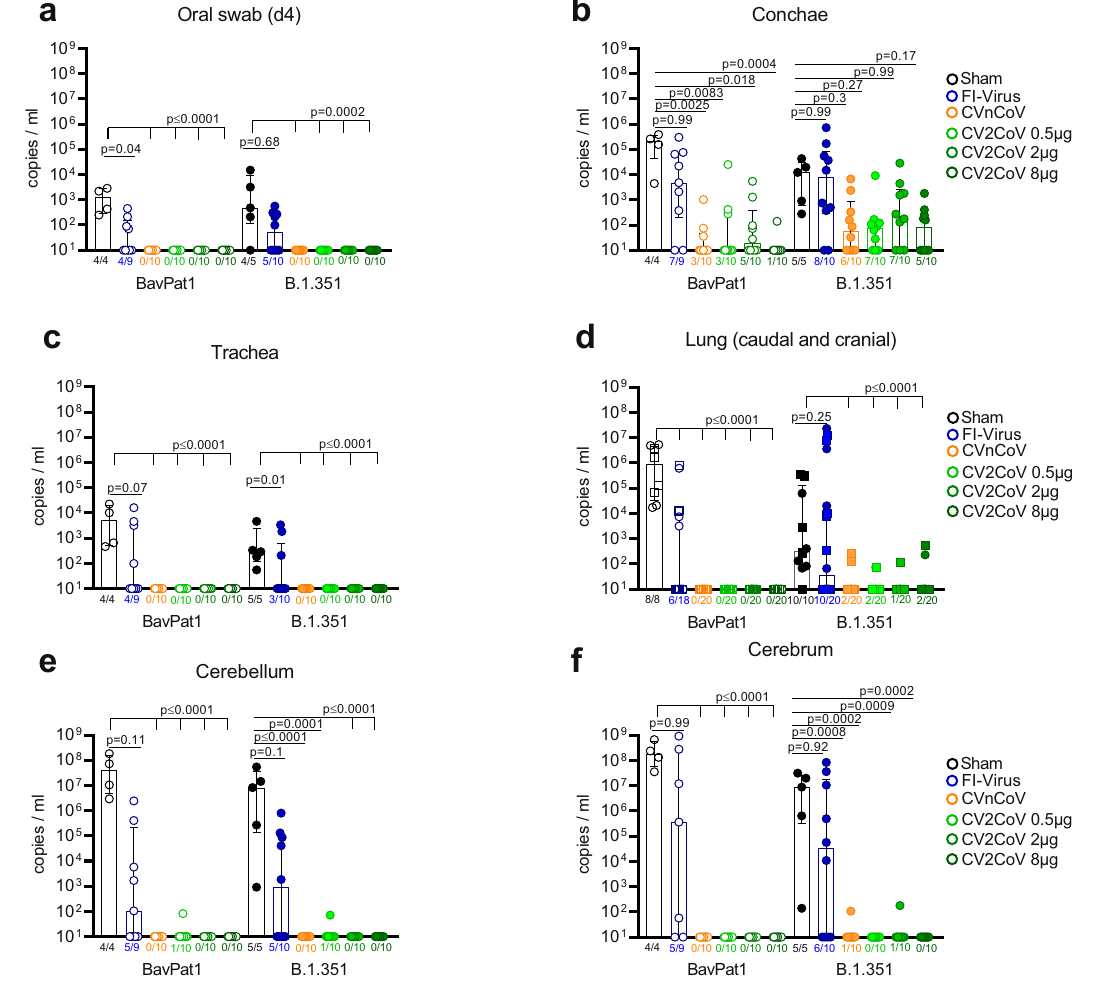
Fig. 2 CVnCoV and CV2CoV prevent replication of SARS-CoV-2 variants BavPat1 and B.1.351 in K18-hACE2 mice. RT-qPCR for genomic RNA of SARS- CoV-2 was performed with a oral swab samples at day 4 or from organ samples of b the upper respiratory tract, c , d the lower respiratory tract (caudal lung = circle; cranial lung = squares), and e , f the brain at day 10 or at the humane endpoint. Mice that were vaccinated with 8 µ g CVnCoV (orange) or different concentrations of CV2CoV (0.5 µ g (light green), 2 µ g (green) or 8 µ g (dark green)), received 10 6 FI-Virus (blue) or NaCl (black) (sham) on days 0 and 28 followed by i.n. challenge with 10 5.9 TCID 50 of SARS-CoV-2 variant BavPat1 or 10 5.5 TCID 50 B1.351. Each dot represents one individual mouse. Each sample was tested once, and assays were repeated at least once. p Values were determined by nonparametric one-way ANOVA and Dunn ’ s multiple comparisons test. Scatter plots are labeled with median (height of the bar) and interquartile range. Differences were considered signi fi cant at p < 0.05, with exact p values displayed in the fi gure. Source data are provided as a Source data fi